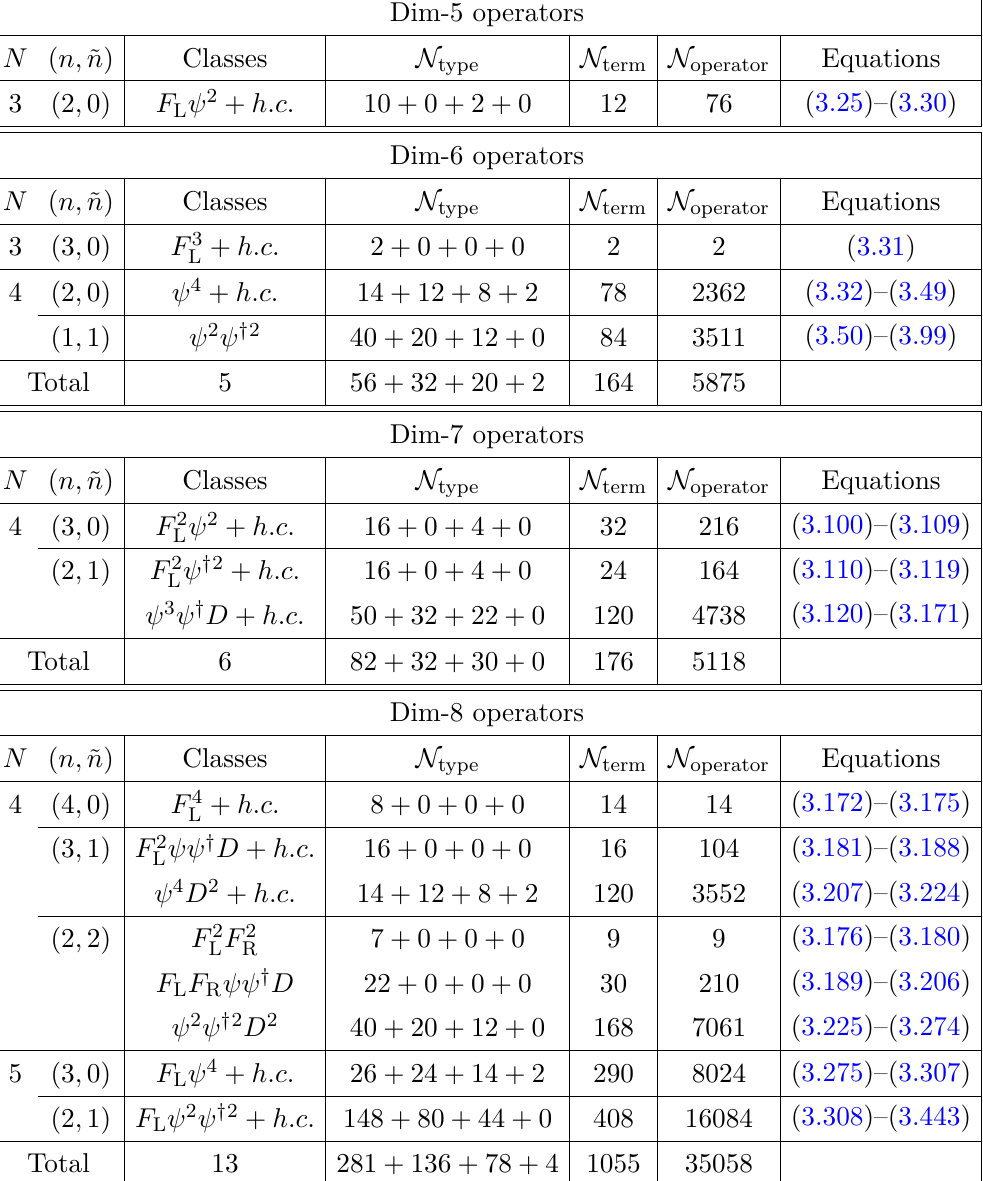
Table 2 . The complete statistics of dimension 5, 6, 7, 8 LEFT operators. N in the leftmost column shows the number of particles. ( n, ˜ n ) are the numbers of (cid:15) and ˜ (cid:15) in the Lorentz structure. N type , N term , and N operator show the number of types, terms and Hermitian operators respectively (independent conjugates are counted), while the numbers under N describe the sum of each type possible | ∆ L | types/operators with N = N ( | ∆ L | = 0)+ N ( | ∆ L | = 1)+ N ( | ∆ L | = 2)+ N ( | ∆ L | = 4) . The links in the rightmost column refer to the list(s) of the terms in given